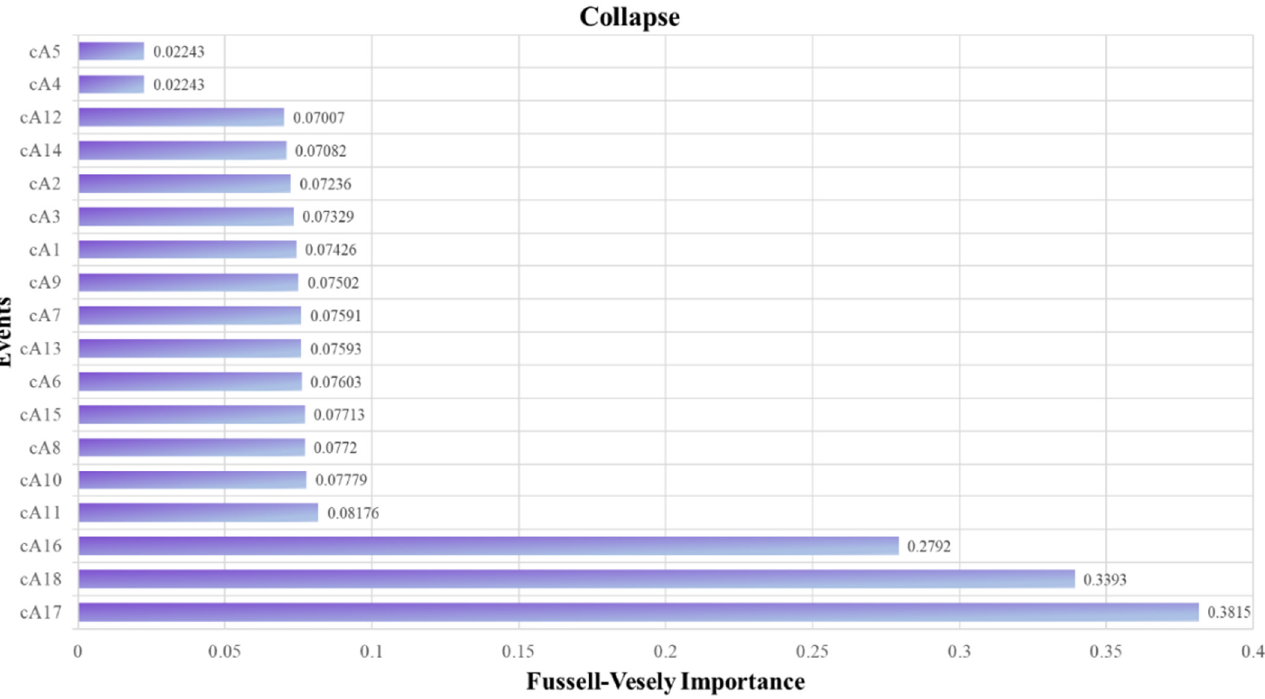
Figure 4. Fussell–Vesely Importance of each basic event of collapse accident.